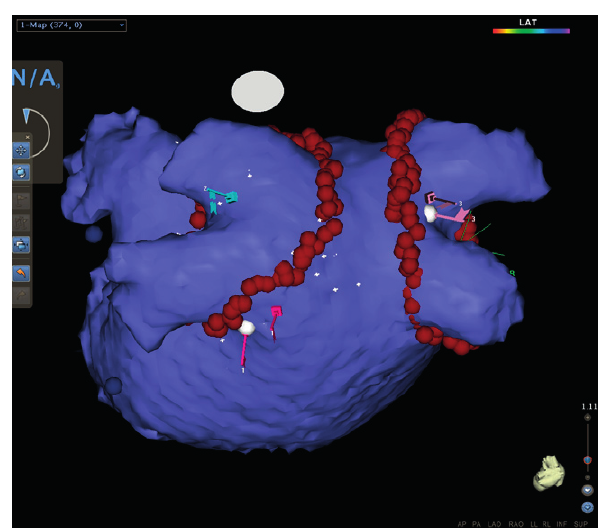
Fig. 1. CARTO3 anatomical model of left atrium. Wide encircling lesions around ostia of ipsilateral pulmonary veins. Red dots = ablated